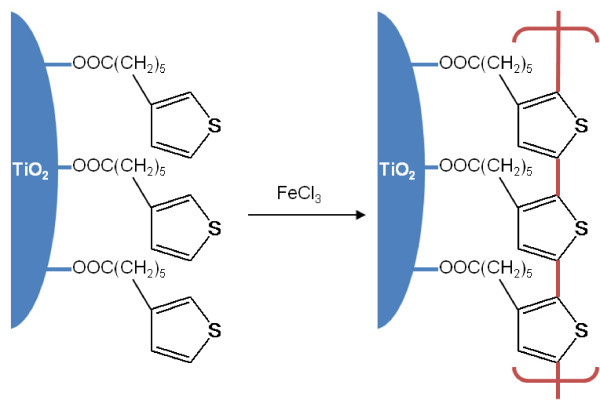
Surface-bound polymerization of THA to PTHA on surface of a TiO2 nanocrystallite. The monomer THA was strong bonded to TiO2 surface via -COOH. FeCl3 was used as an oxidizing agent to polymerize the surface-bound THA to its corresponding polymer PTHA.